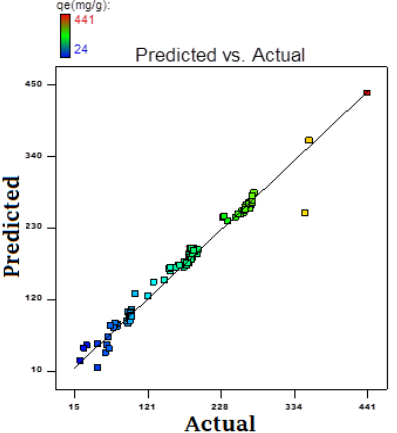
Figure 9. Actual versus predicted values of AR119–NICUS system.